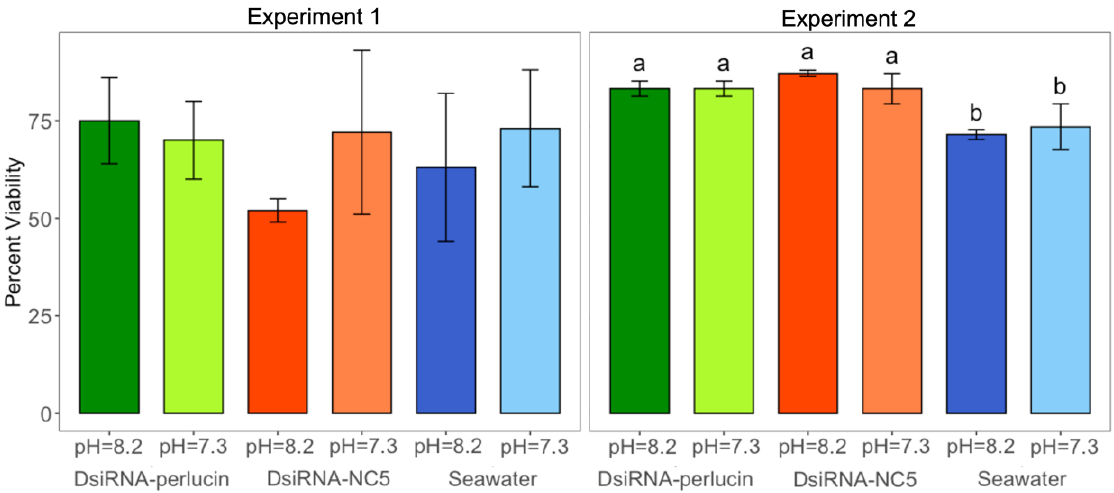
Figure 3. Viability (mean ± sd) of silenced (DsiRNA-perlucin (green)) and control (DsiRNA-NC5 (orange) and seawater (blue)) oyster larvae cultured under different p CO 2 treatments (lighter shades for pH=7.3 and darker for pH=8.2). Different letters (a and b) denote significant differences (1-way ANOVA, n = 3, p -value <0.05) in Experiment 2 (no significant differences were identified for Experiment 1). Larvae were sampled on day 3 for Experiment 1 and day 5 for Experiment 2.